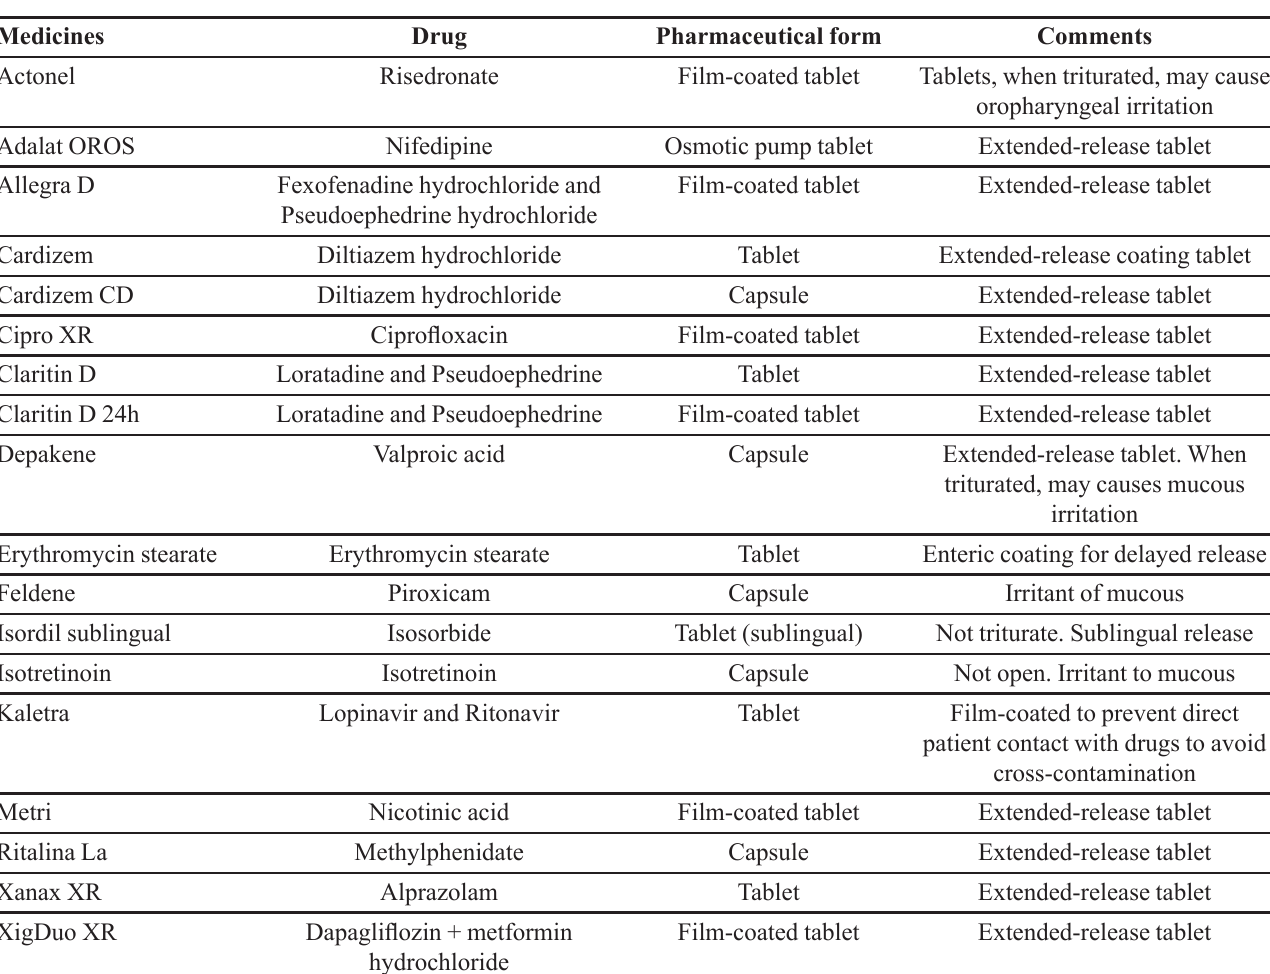
TABLE II - Oral solid pharmaceutical forms that cannot be triturated and